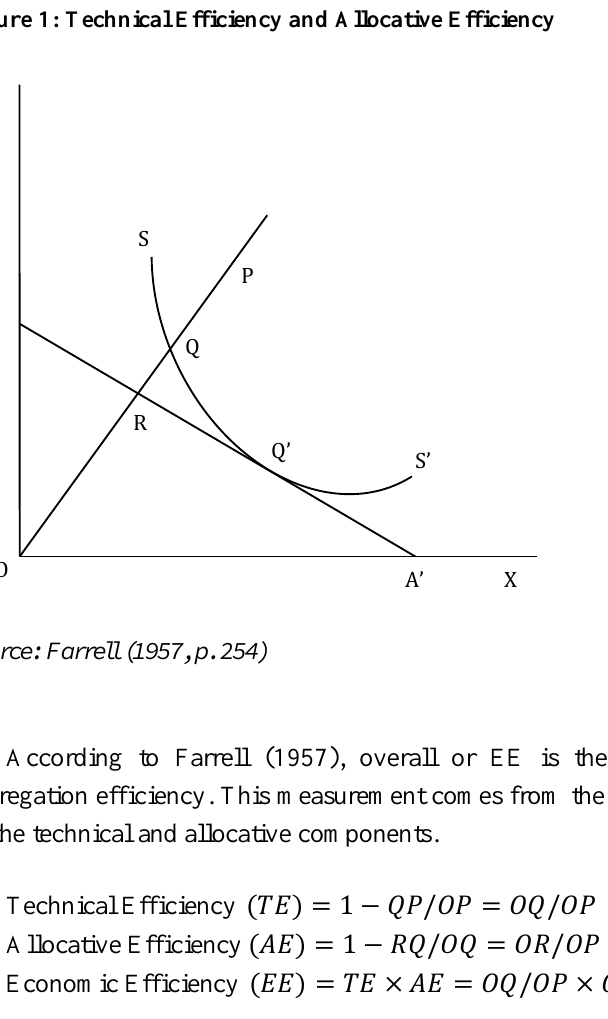
Figure 1: Technical Efficiency and Allocative